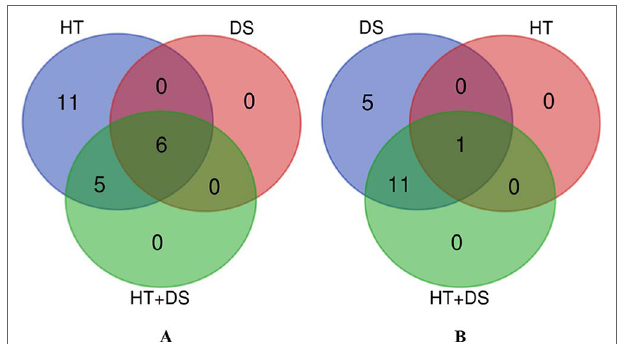
FIGUrE 2 | Venn diagrams of the relative changes in expression for 23 genes encoding enzymes involved in starch biosynthesis in the high temperature (HT), drought stress (DS), and HT+DS treatments compared with the CK. (A) Down-regulated gene expression; (B) up-regulated gene